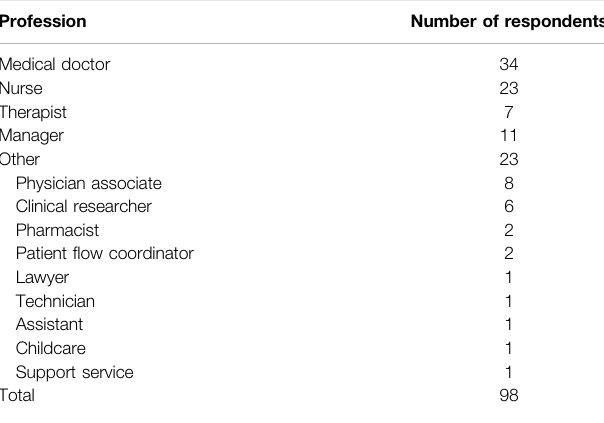
TABLE 2 | Various professions of survey